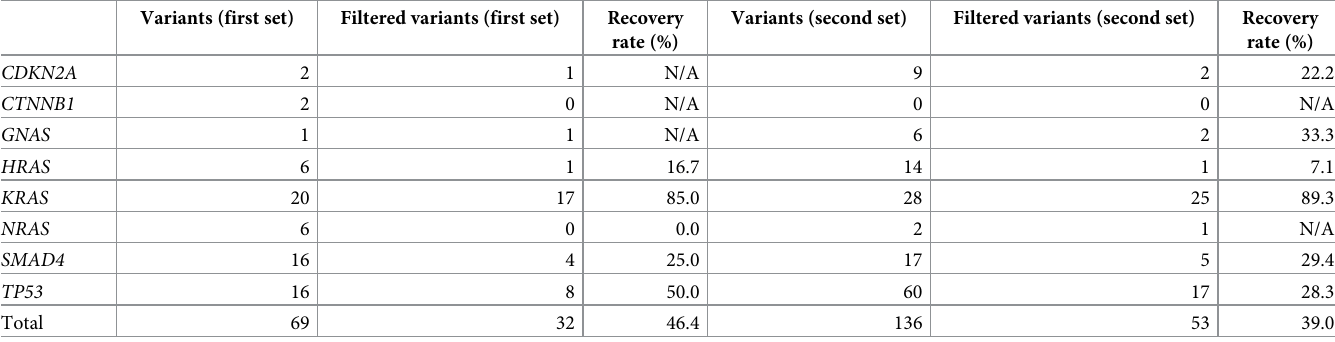
Table 3. Variants classified in each